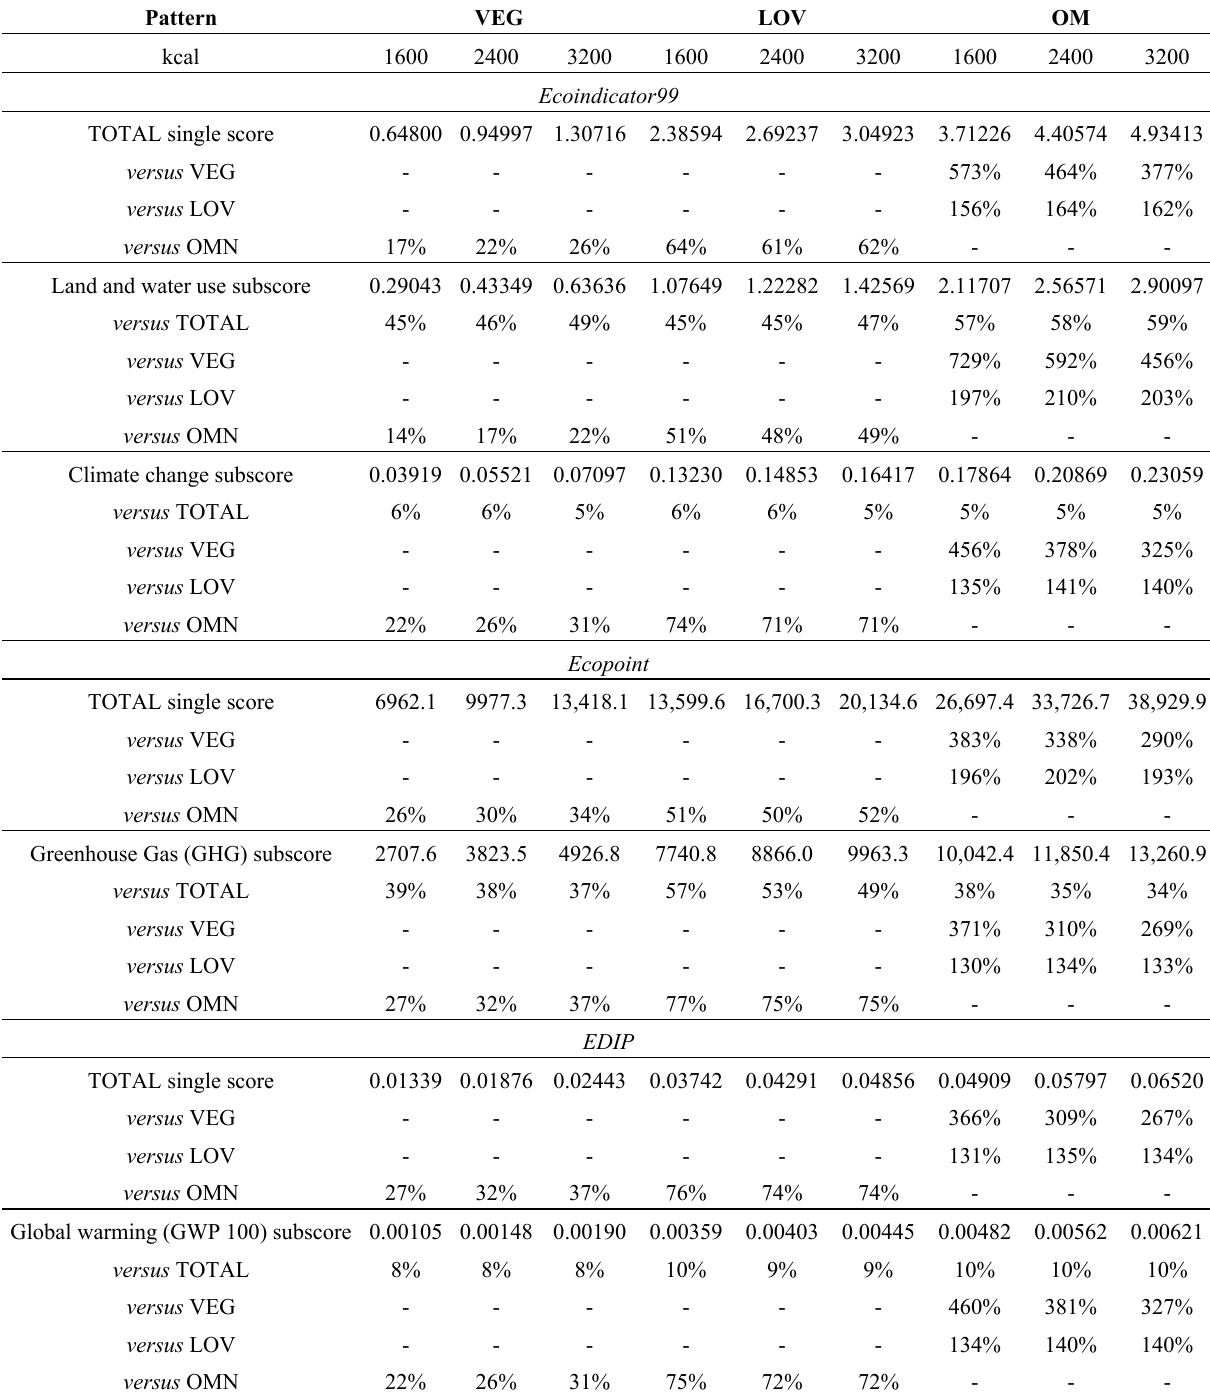
Table 3. Whole diet study: land and water use, and GHG subscores (indicated as single score, Pt per week) of the three complete food patterns, according to each